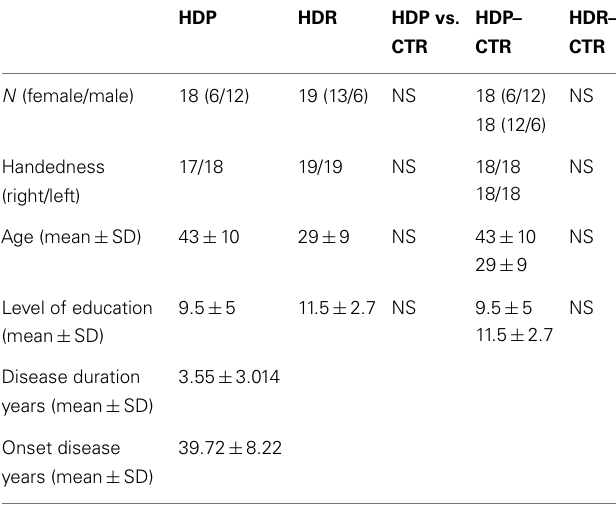
Table 1 | Demographic and clinical data